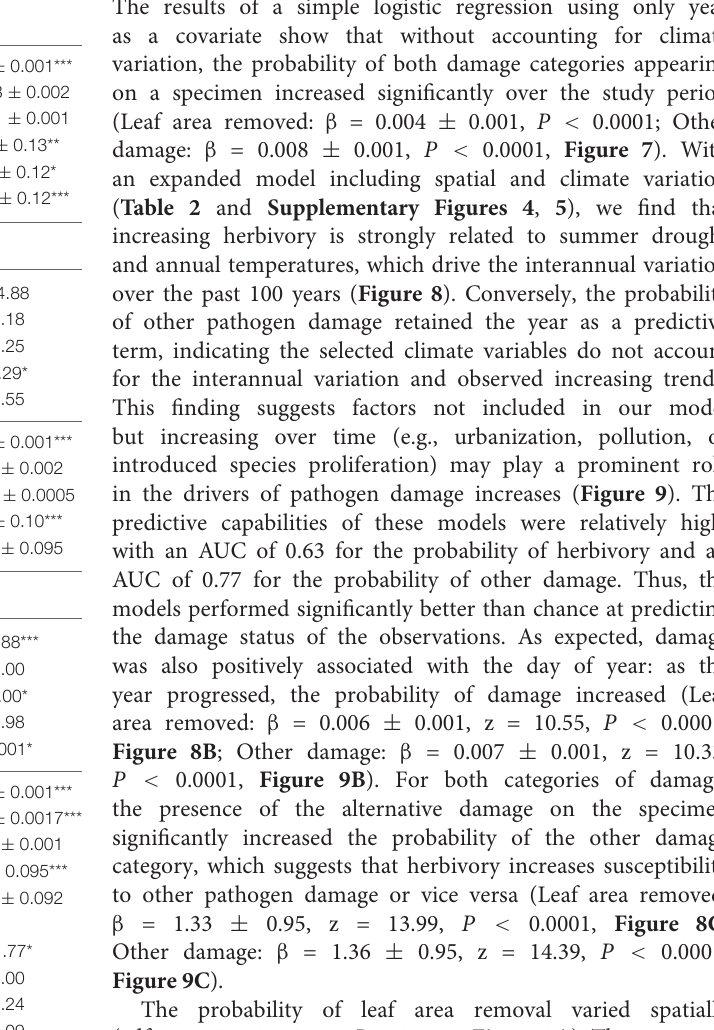
Figure 8B ; Other damage: β = 0.007 ± 0.001, z = 10.33, P < 0.0001, Figure 9B ). For both categories of